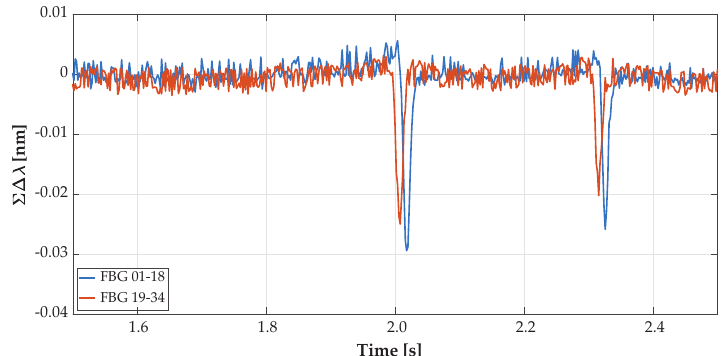
Figure 10. Record detail of the summary values of the wavelength changes (of the reflected optical spectrum by FBG) shifted by Nothing-on-Road (NoR) values.